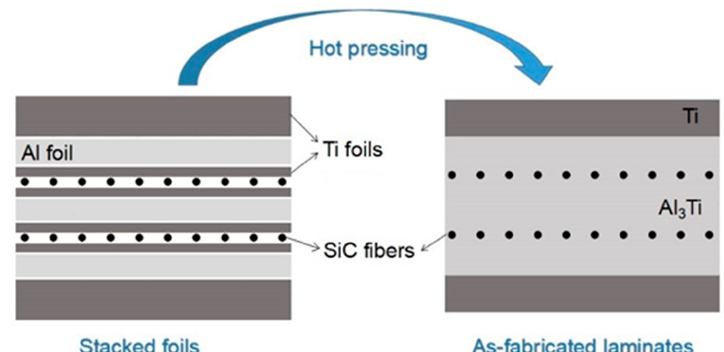
Figure 1. Schematic illustration of the fabrication process of the Ti-(SiC f /Al 3 Ti)-laminated composite using a Ti barrier layer.